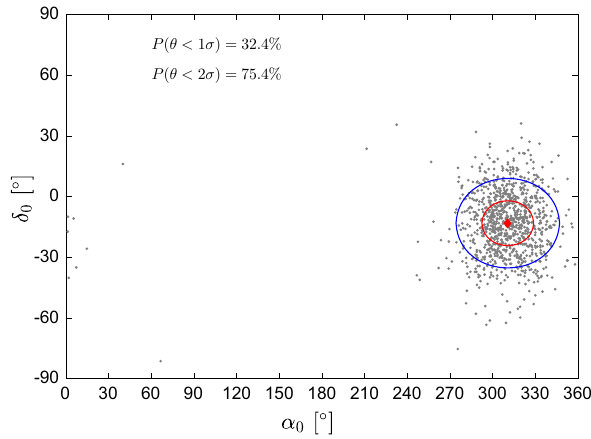
Fig. 4 Thedistributionofpreferreddirectionsin1000simulationswith 800 GW events in each simulation. The red and blue error ellipses are the 1 σ and 2 σ confidence regions of Unin2.1, respectively